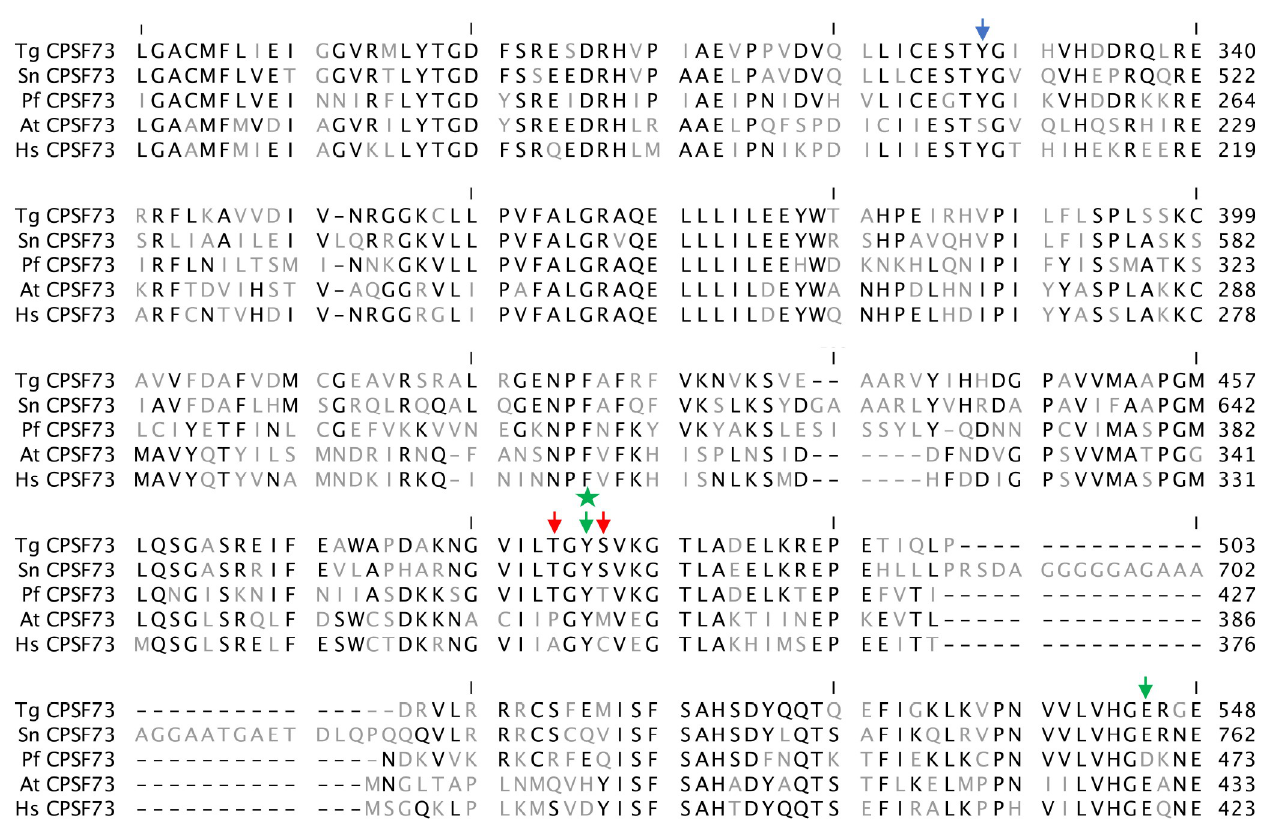
Fig 2. Amino acid sequence alignments of orthologs of CPSF73. Alignments were performed using the default settings in CLC Genomics Workbench. Amino acid residues that are identical in all five sequences are shown in black, and other residues in gray. Residues that are altered in T . gondii AN3661-resistant mutants are denoted with a blue arrow, those altered in resistant P . falciparum mutants in red, and those altered in both T . gondii and P . falciparum mutants in green. The green star denotes the position (Y668 in the S . neurona protein, corresponding to Y483 of the T . gondii CPSF73) that is altered in the five AN3661-resistance S . neurona clones. The alignment is truncated, focusing on the conserved core of the protein. Tg– T . gondii ; Sn– S . neurona ; Pf– P . falciparum ; At– Arabidopsis thaliana; Hs–human. Numbers on the right denote the residue numbers for the respective proteins.